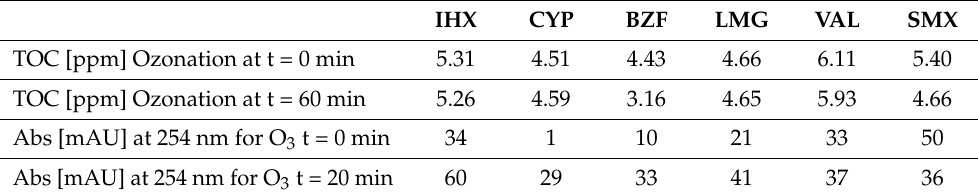
Figure 2. Iohexol and its major transformation products. Table 1. Pharmaceutical compounds TOC and absorbance at 254 nm.